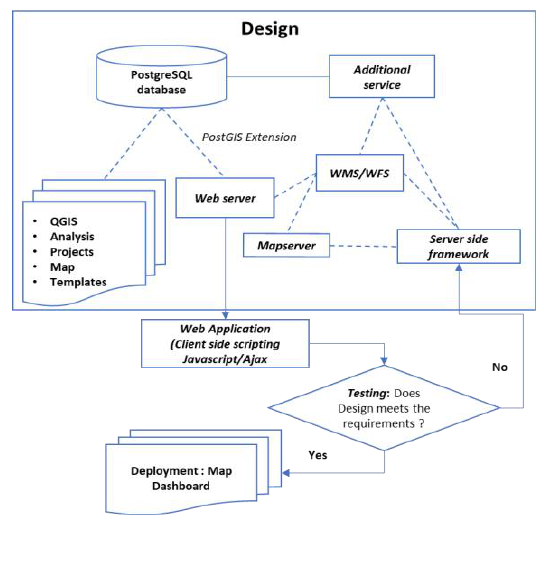
Figure 7 : Web GIS Application Design Workflow